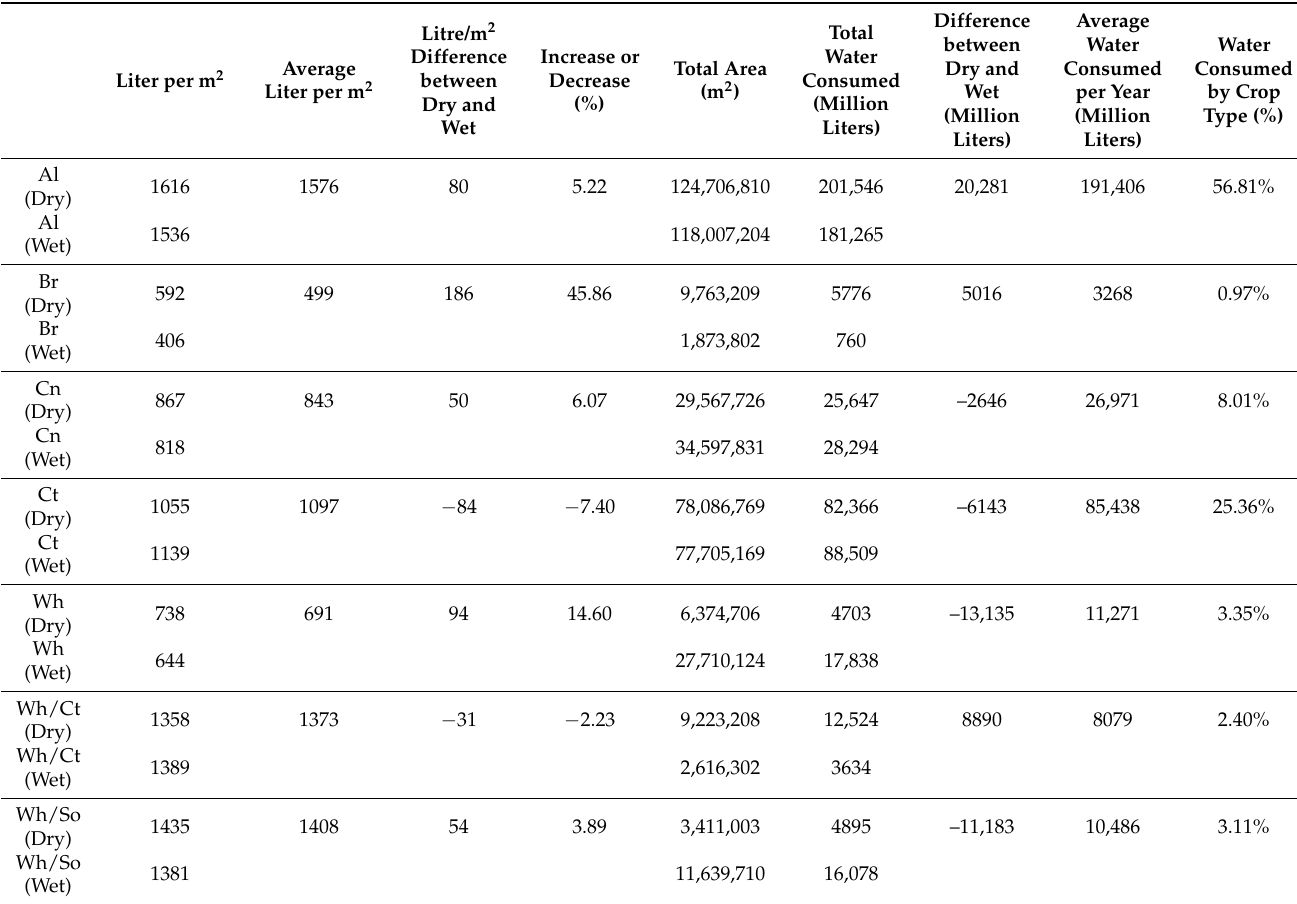
Table 6. Difference in water consumption between dry and wet years by crop type (Al = Alfalfa; Br = Barley; Cn = Corn; Ct = Cotton; Wh = Wheat; So =